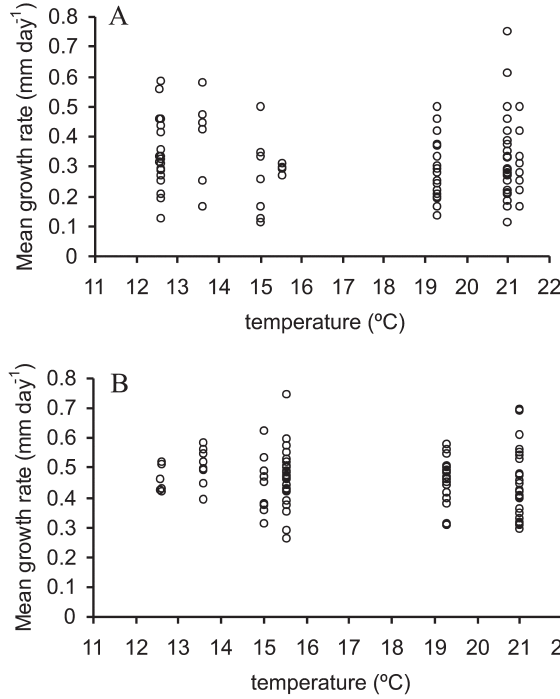
Fig . 7. – Scatter plot of recent growth rate estimated four days be- fore capture (G4) on surface water temperature. A) size interval: 4 – 6 mm, B) size interval: 4.1 - 6